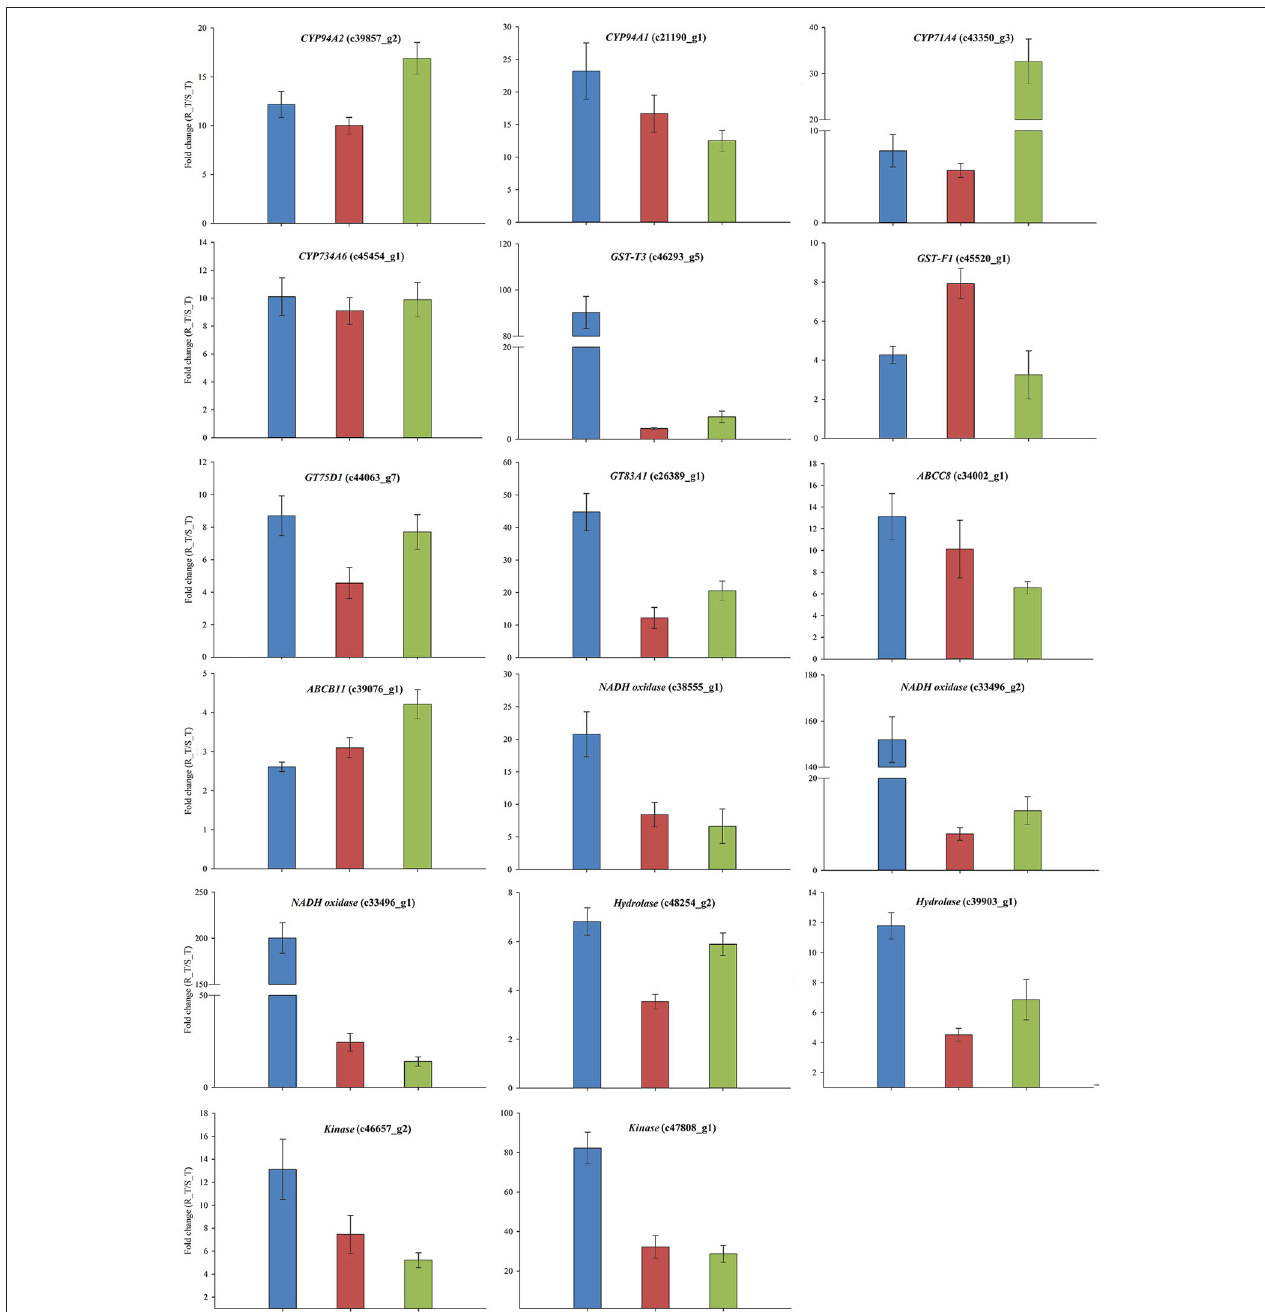
FIGURE 8 | The qRT-PCR validations of the 17 genes that had a consistently up-regulated expression in the R Alopecurus aequalis samples. Blue bars represent the RNA-Seq; red bars represent the qRT-PCR validation that used the RNA-Seq samples; and green bars represent the qRT-PCR validation that used the parallel plant materials. Both UBQ and GAPDH were used as the internal control genes. Means and their SEs from three biological replicates are